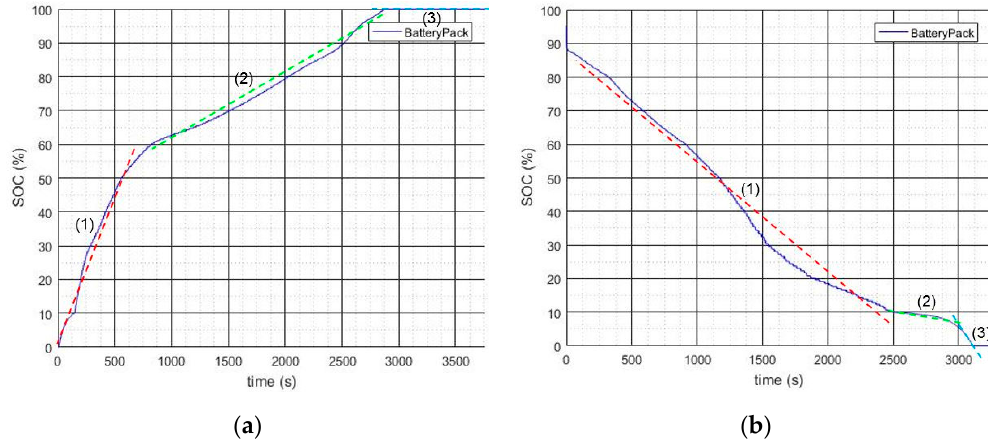
Figure 2. State of charge (SOC)–time curve obtained using a 3.3 Ah 4S1P Li-Po battery pack using a 1 C charging and discharging current pattern: ( a ) Charging curve and ( b ) discharging curve.